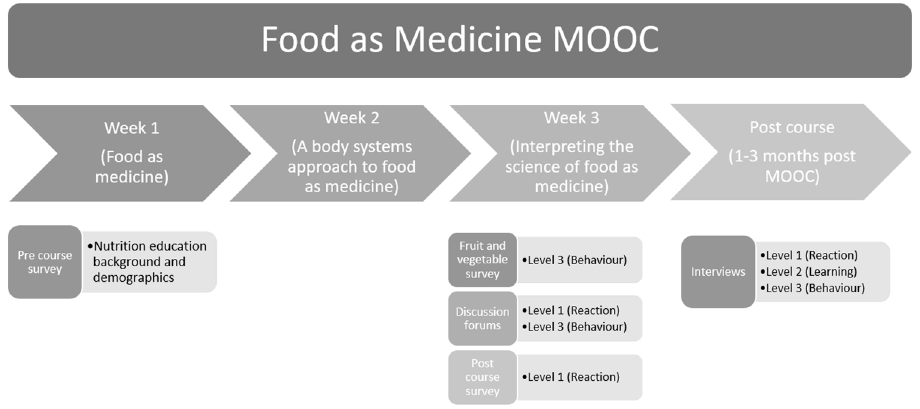
Figure 1. Data collection sources from different stages of the MOOC. Table 1. Evaluation methods and corresponding levels of NWKM.